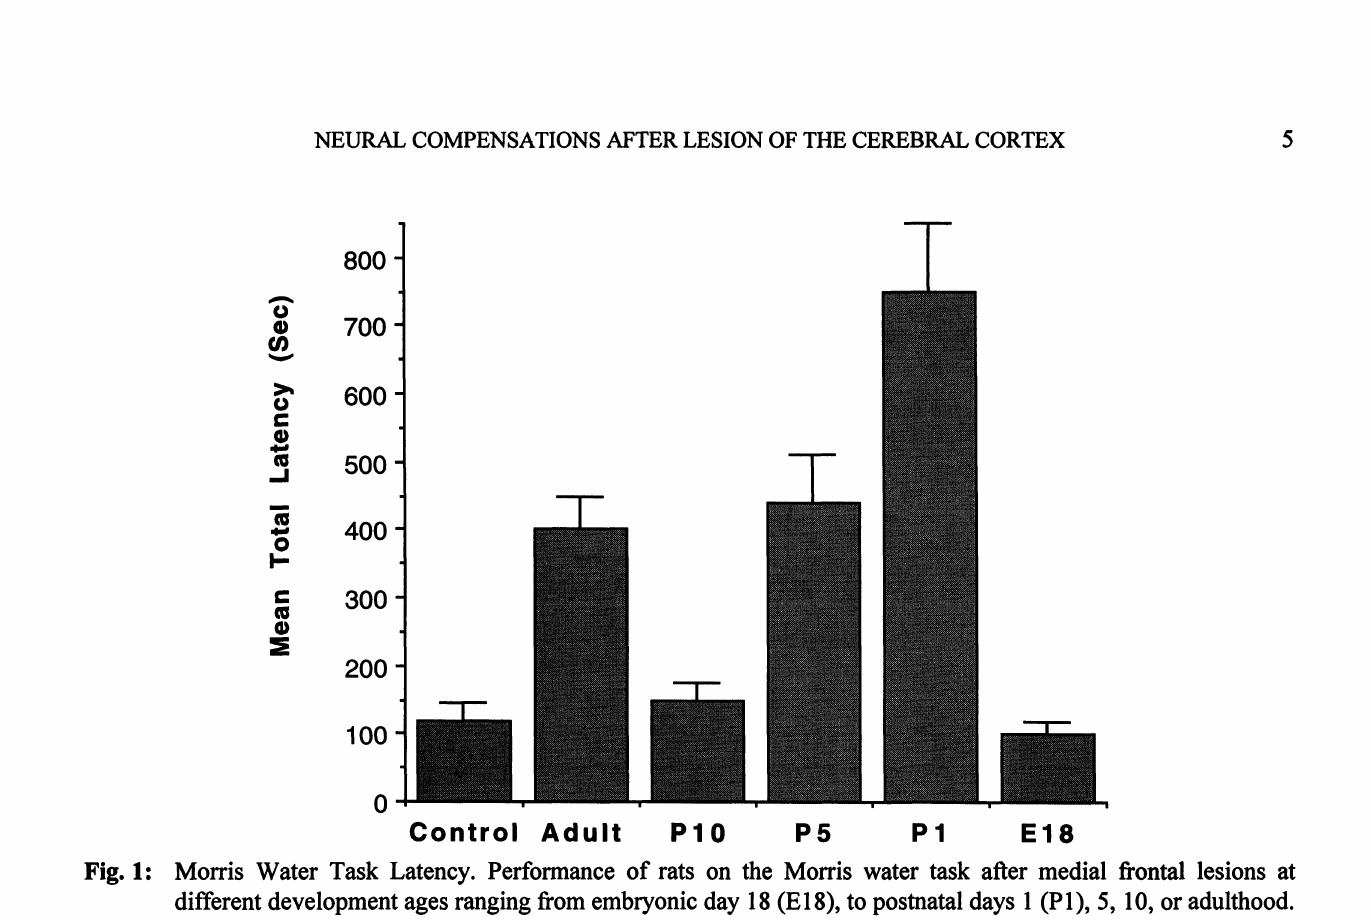
Fig. 1: Morris Water Task Latency. Performance of rats on the Morris water task after medial frontal lesions at different development ages ranging from embryonic day 18 (E18), to postnatal